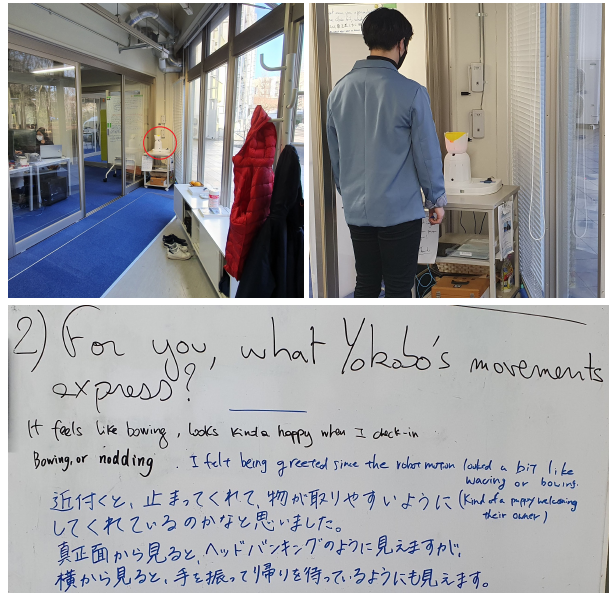
Figure 4. Y¯okobo in the experimental condition, and the graffiti wall , with, in this case, question 2 and the answers. The translations for the Japanese answers are: “I thought Yokobo thoughtfully stops its head as I approach to it so that I can pick stuff from the bowl easily.” and “It appears to be shaking the head hard from front point of view, however, it looks like waving the hand and waiting for people from side point of